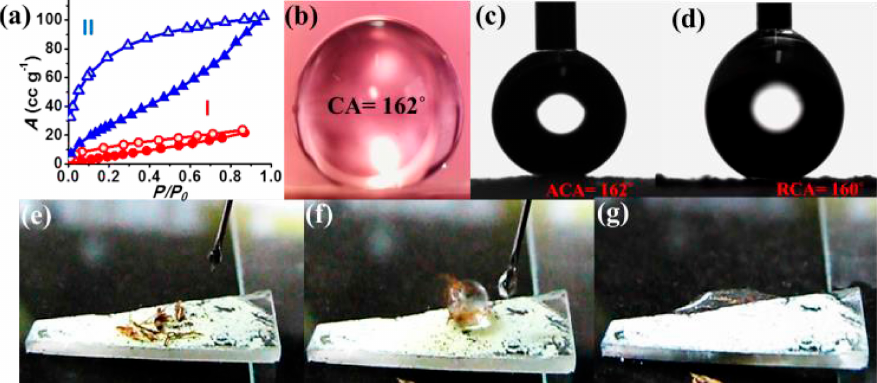
Figure 9. ( a ) Solvent vapor adsorption isotherms of NMOF- at 298 K: I: Water (red) and II: benzene (blue), Po is the saturated vapor pressure, 3.17 kPa (water) and 12.60 kPa (Benzene) at 298 K. Water contact angles of NMOF-1 coated substrate; ( b ) Static contact angle; ( c ) advancing contact angle and ( d ) receding contact angle ( e – g ) video snapshots of a self-cleaning experiment showing the removal of dirt from the surface. Reprinted with permission [64] Copyright 2015, Royal Society of Chemistry.